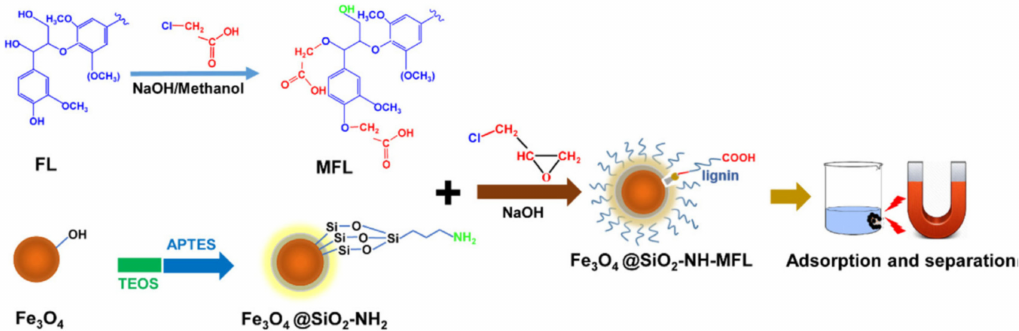
Figure 4. A schematic process flow diagram illustrating the synthesis of the lignin-based hybrid magnetic nanoparticles. Adapted with permission from Reference